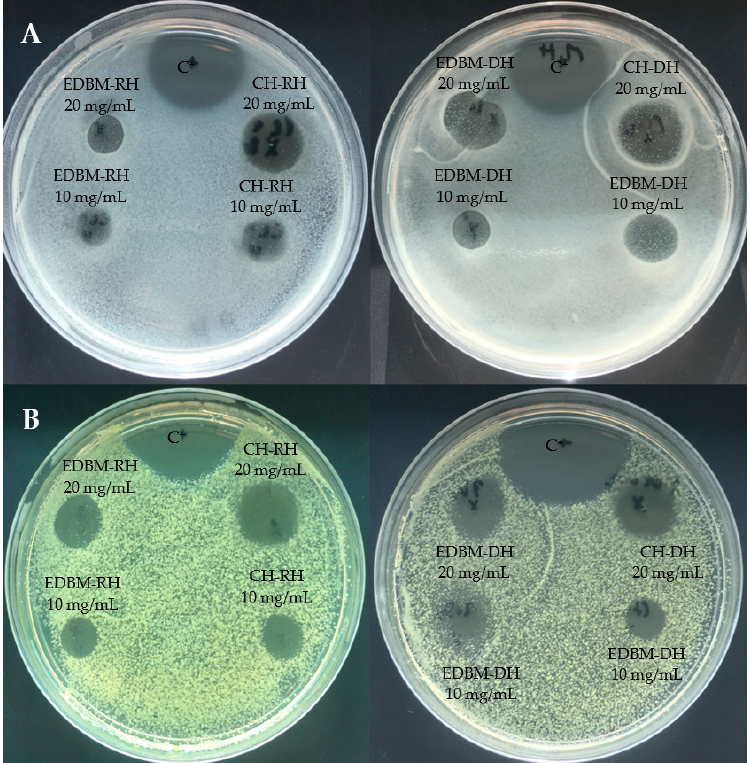
Figure 3. Inhibition zones induced by 2 different concentrations (10 and 20 mg/mL) of raw and discolored bovine hemoglobin hydrolysates produced by two different hydrolysis processes on Muller-Hinton Agar overlaid with a suspension (10 6 strain per plate) of Staphylococcus aureus ( A ) and Kocuria rhizophila ( B ) and compared to a positive control (C + :